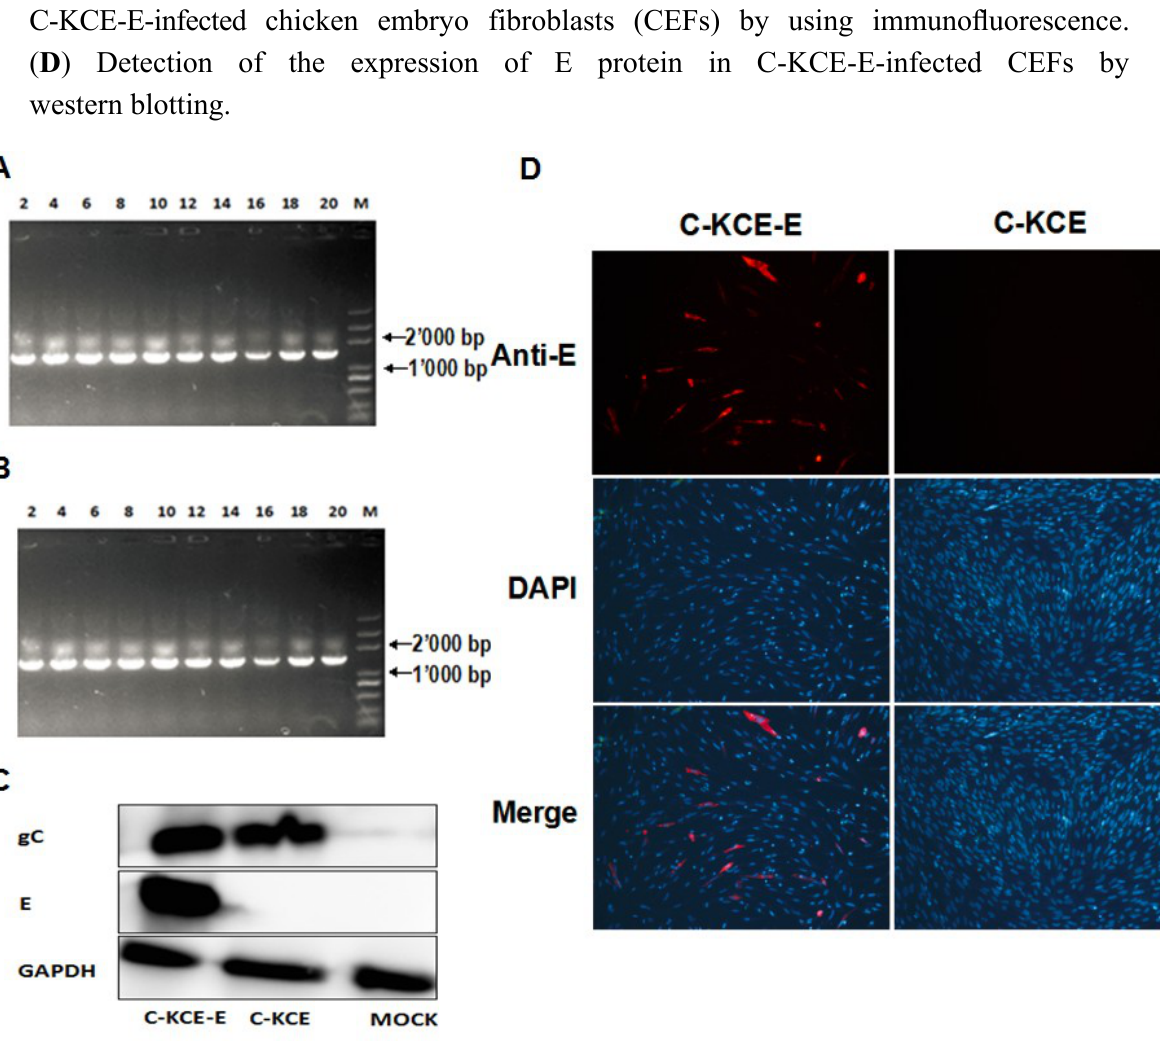
Figure 5. The efficiency of E gene insertion in the pBAC-C-KCE base using MAGIC and characterization of the recombinant C-KCE-E viruses. ( A ) Detection of the E gene insertion